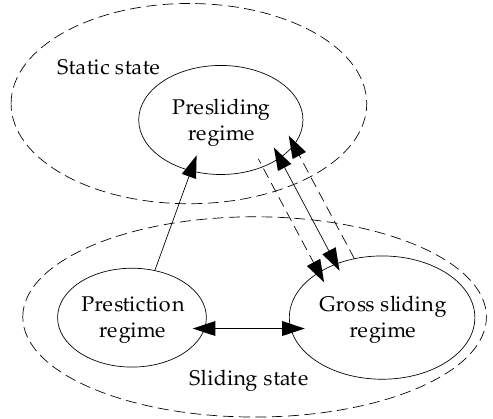
Figure 10. Transition diagram of friction regime [75].